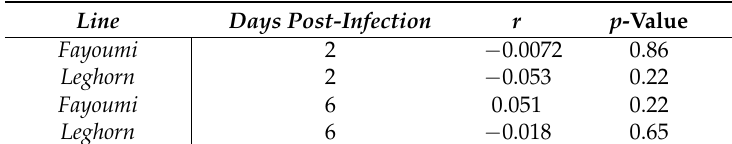
Table 3. Correlation coefficients and p -value statistics calculated between the log 2 (fold change) in gene expression and the log 2 (fold change) in protein abundance between treated and non-treated birds at each timepoint.